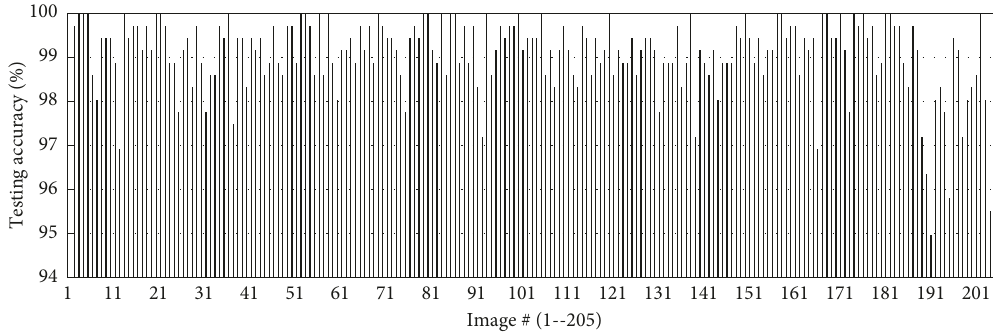
Figure 10: Testing accuracies of 205